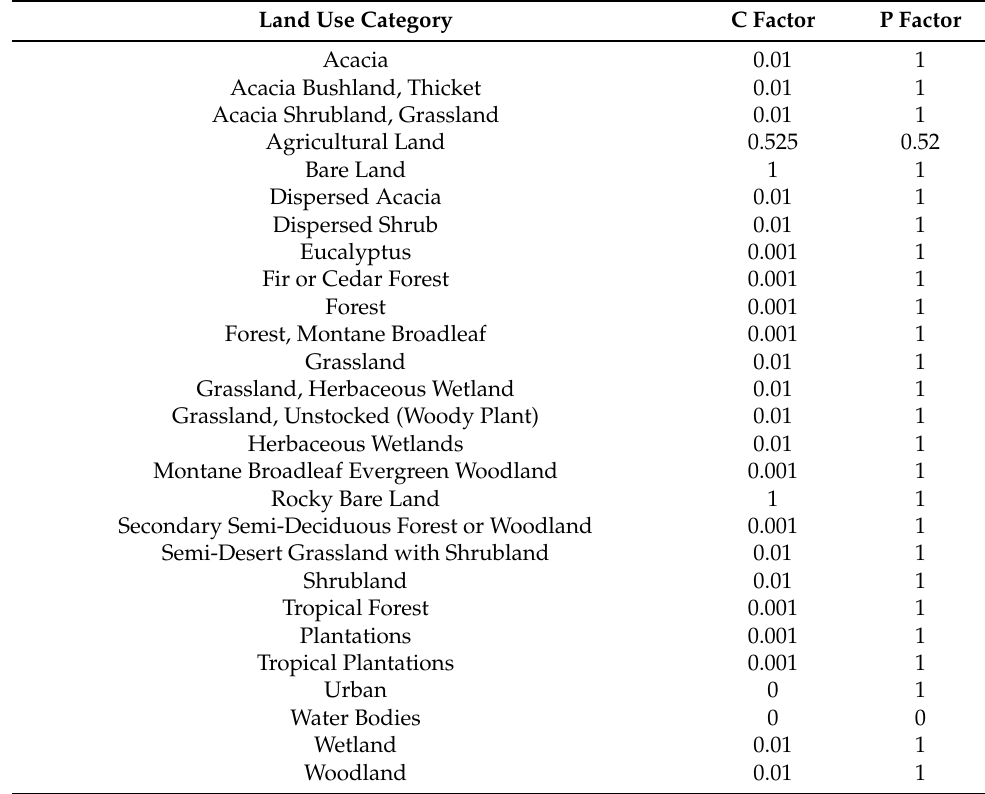
Table 1. The assigned cover and conservation practice factors for each land use of the watersheds under our